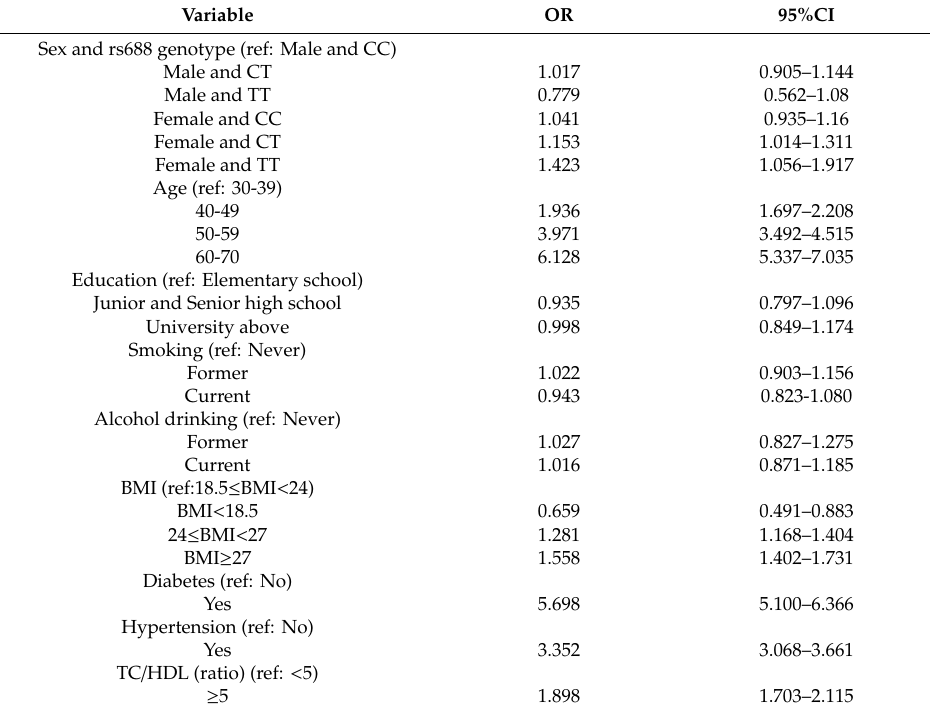
Table 5. Odds ratio for hyperlipidemia according to gender and rs688 genotypes.